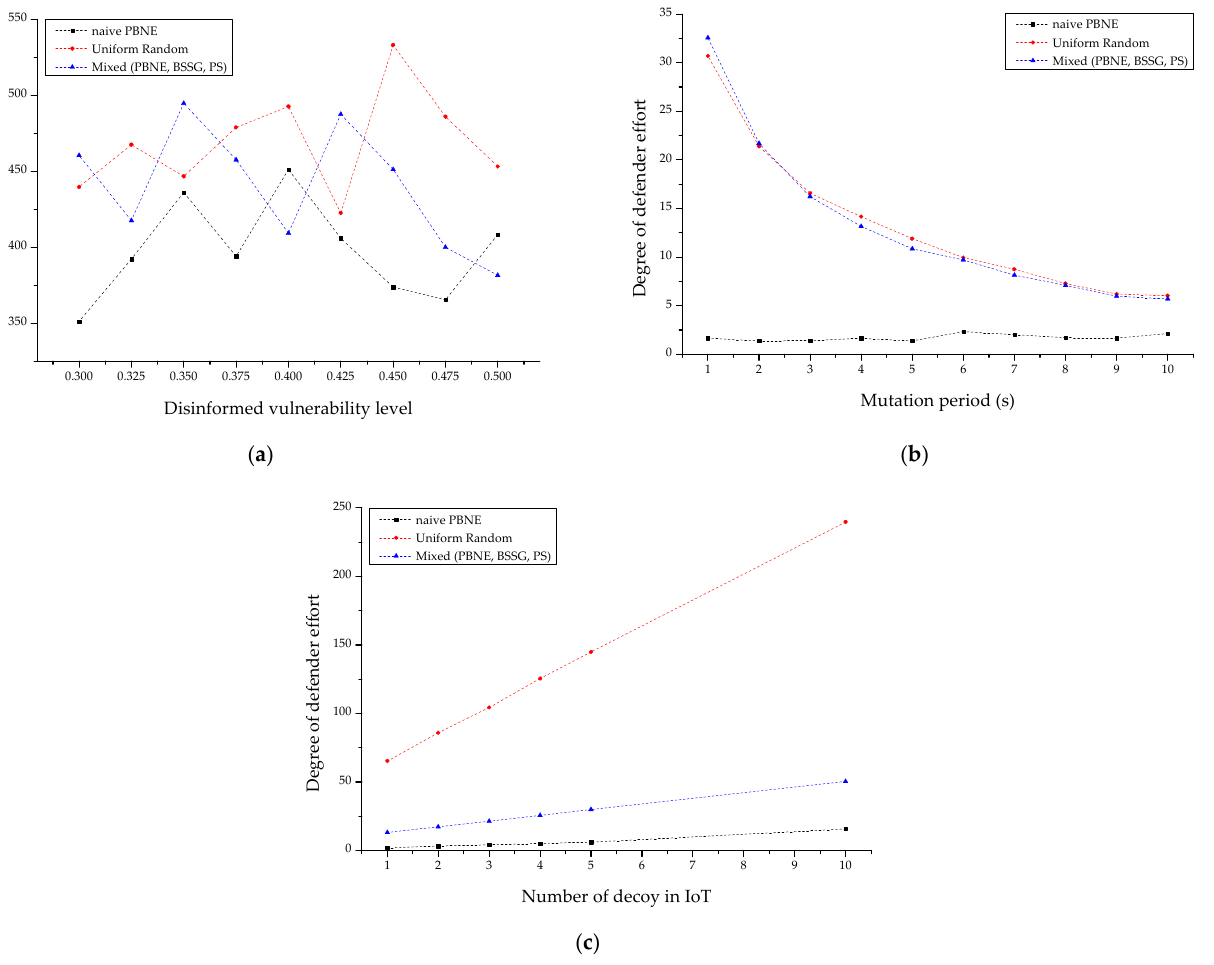
Figure 12. Comparison of the defense utility with deceptive signal each decision scheme in Scenario2. ( a ) artificially exposed vulnerability level, ( b ) mutation time slot length, and ( c ) number of IoT-enabled decoy hole.